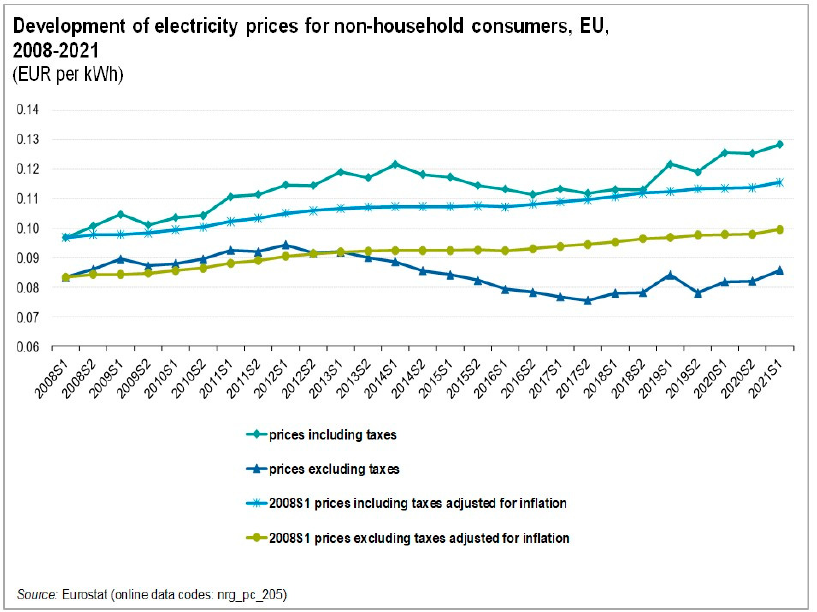
Figure 6. Development of electricity prices for non ‐ household consumers, EU, 2008–2021 [29].